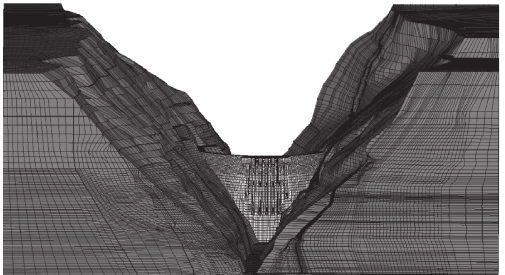
Figure 5: Three-dimensional finite element model of the dam (upstream